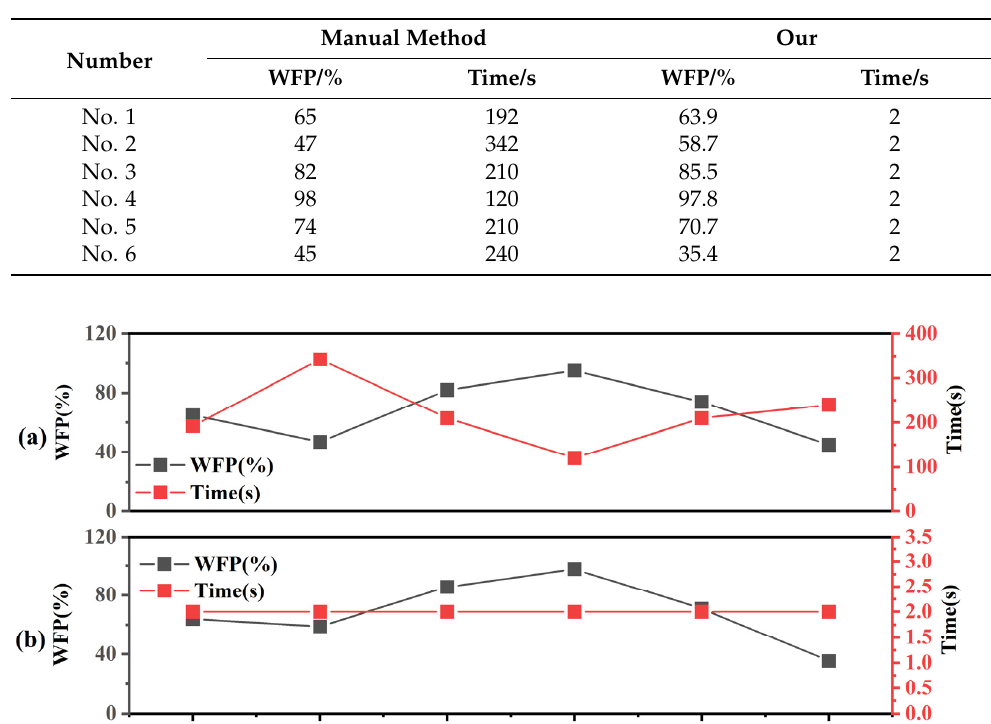
Table 7. Measurement time for both methods.